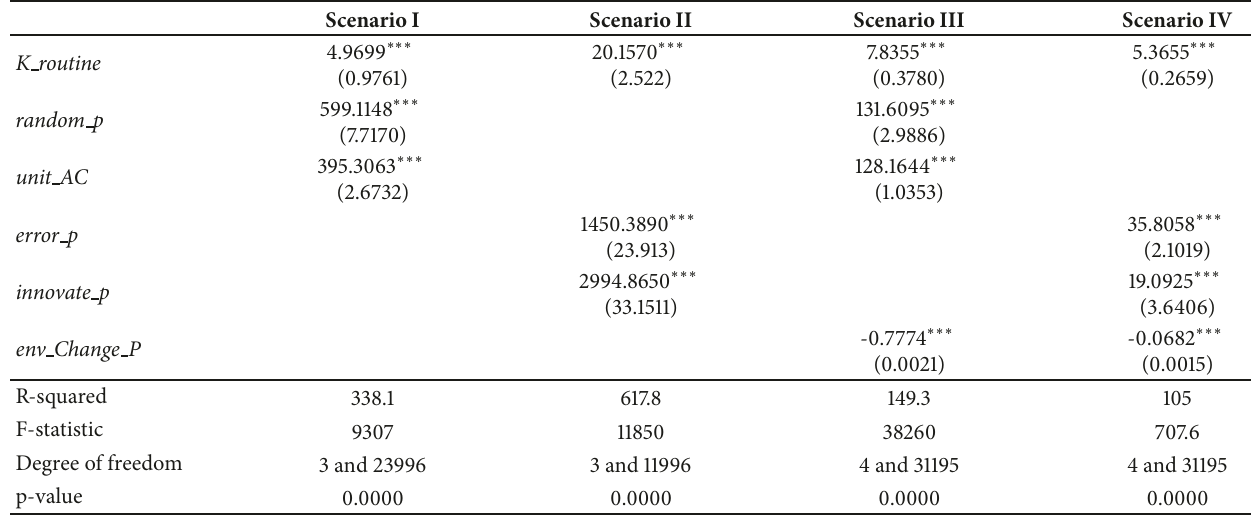
Table 4: Multiple fixed effects panel